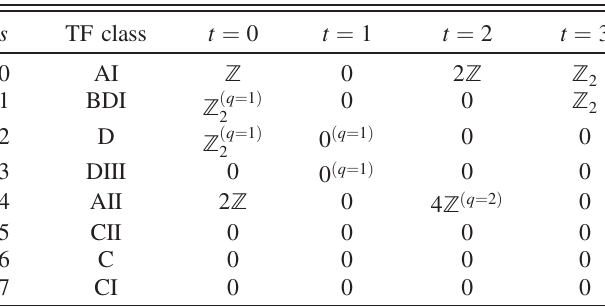
s j 0 ; 0 Þ and K s; t j 0 ; 0 ; 0 ; 0 Þ TF ð TF ; O ð